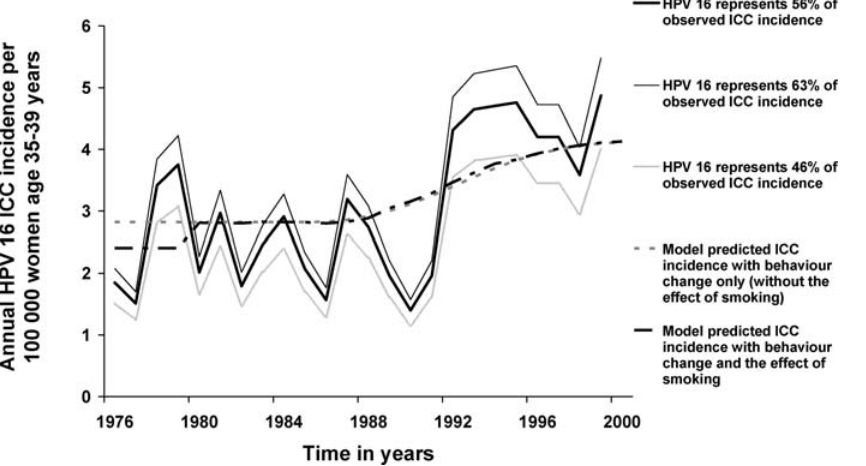
Figure 2. Observed versus Predicted Cervical Cancer Incidence The observed HPV 16 ICC [6] incidence is compared to model predictions. Including the reported changes in sexual behaviour and smoking trends among Finnish women allows the model prediction for HPV 16 ICC incidence to capture an increase in cancer incidence after 1991, but it doesn’t capture the full magnitude of the change. The changes in sexual behaviour, which were reported in 1992, were implemented in the model in 1985, because they could have occurred before 1992. DOI: